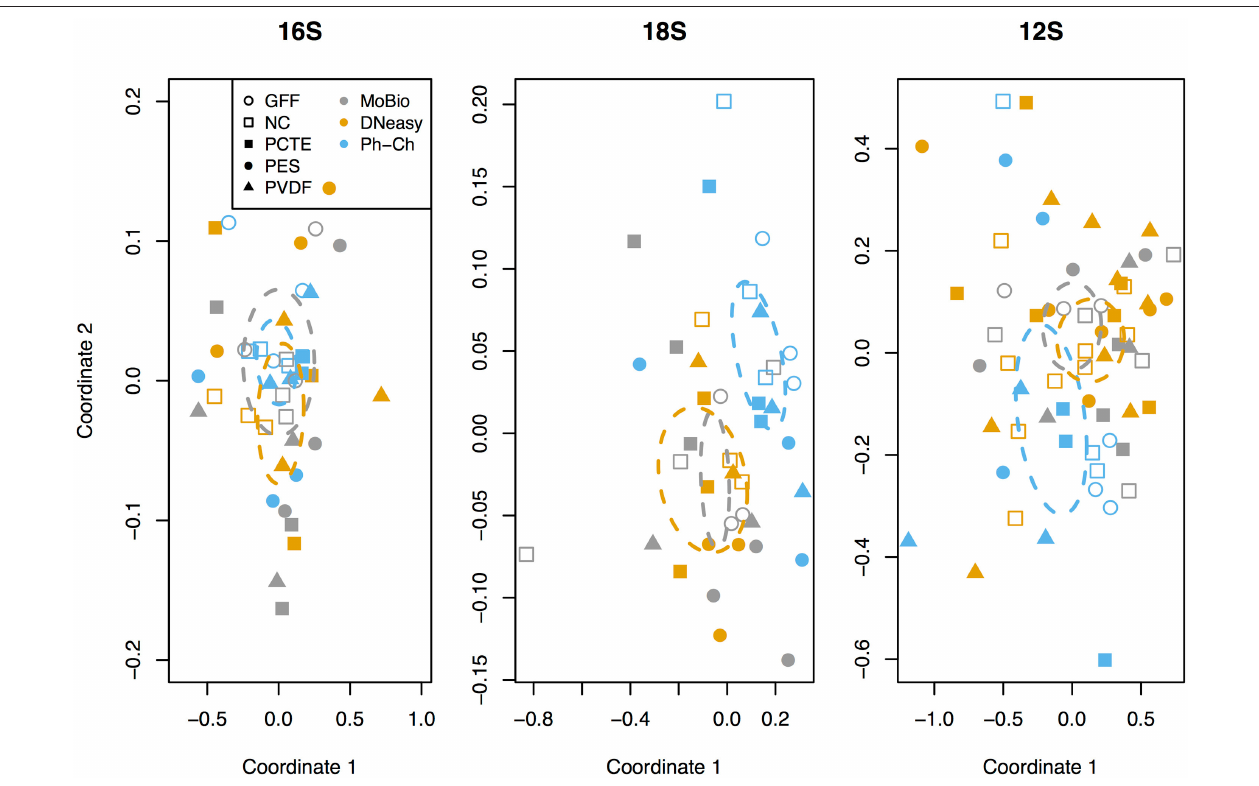
FIGURE 5 | Non-metric multidimensional scaling plot (Bray-Curtis distance metric) for the sequences obtained for the three genetic markers (the 16S rRNA gene, the 18S rRNA gene, and the 12S rRNA gene). Filter types are indicated with different symbols and extraction methods with different colors. The community structure was significantly different between Ph-Ch (phenol/chloroform) and the other two extraction methods for the 12S rRNA gene and the 18S rRNA gene on an OTU level (PERMANOVA: p = 0.0039, df = 2, and p = 0.00199, df = 2, respectively). The ellipses indicate the 95% standard error of each extraction method (indicated by their individual